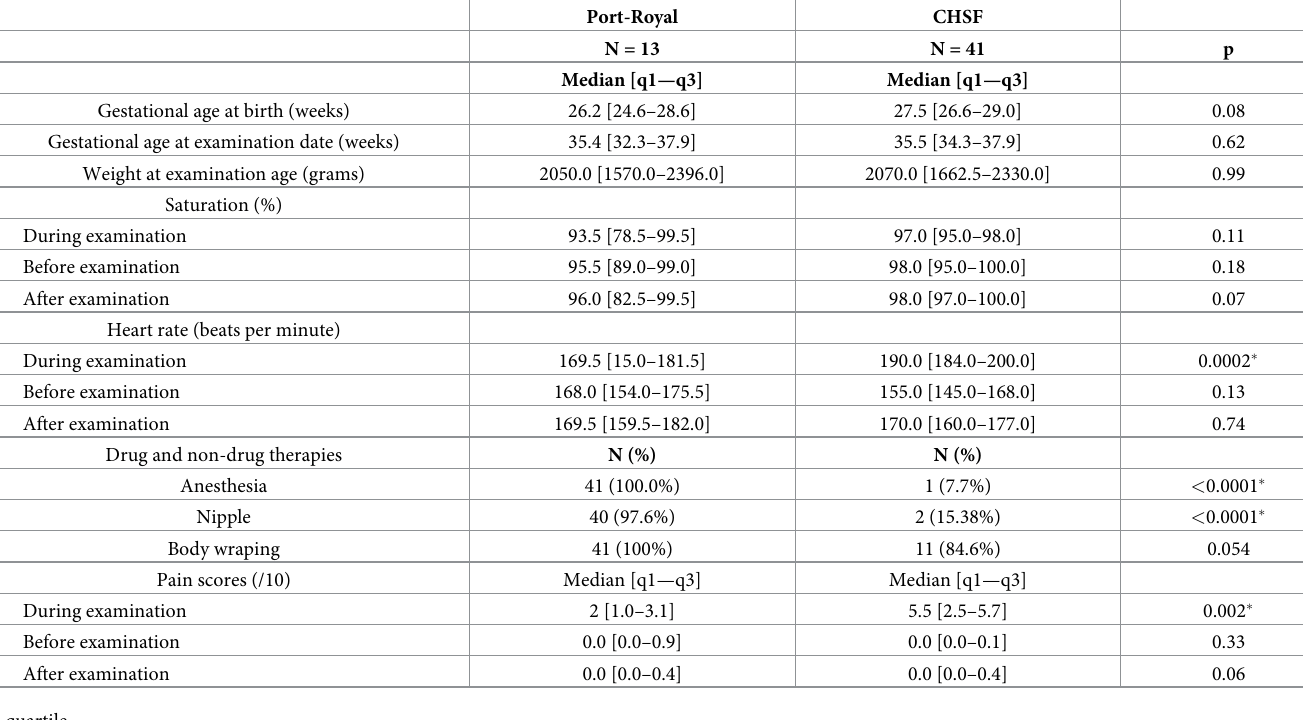
Table 5. Infants characteristics and outcomes for pain evaluation—CHSF and Port-Royal medical centers, after period.